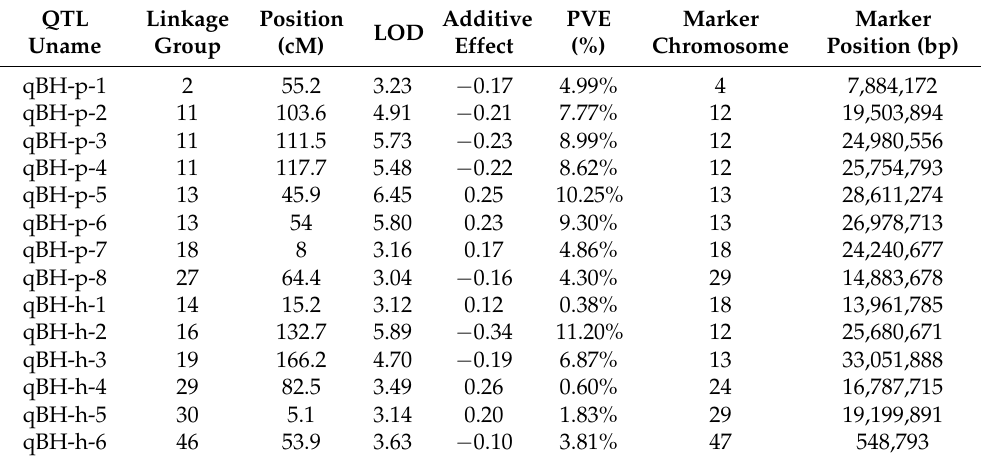
Marker indicates the nearest marker of